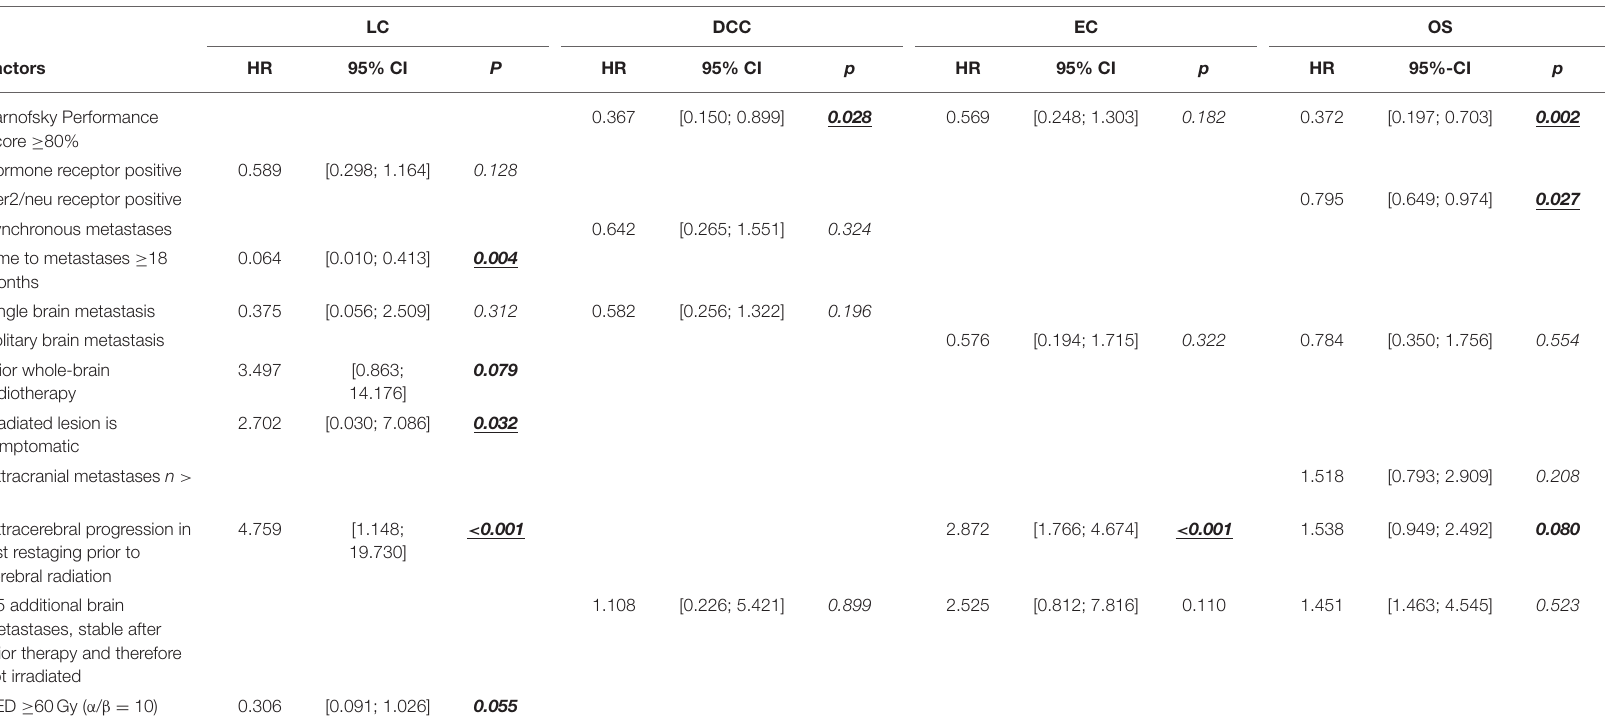
TABLE 2 | Multivariate analysis of prognostic factors influencing local control (LC), distant cranial control (DCC), extracranial control (EC), and overall survival (OS). LC DCC EC OS